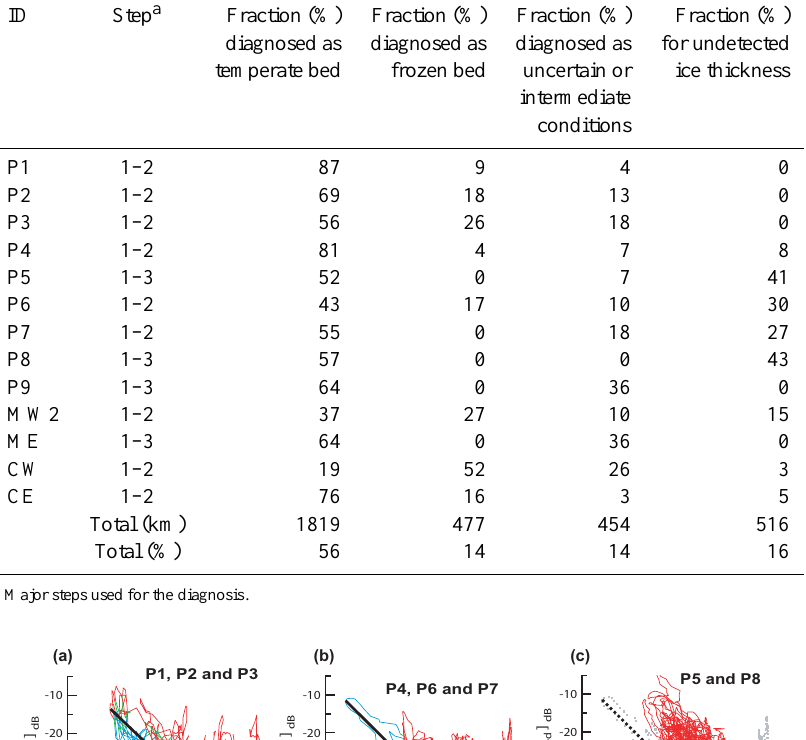
Table 3. Methods of diagnosis and results for each leg.